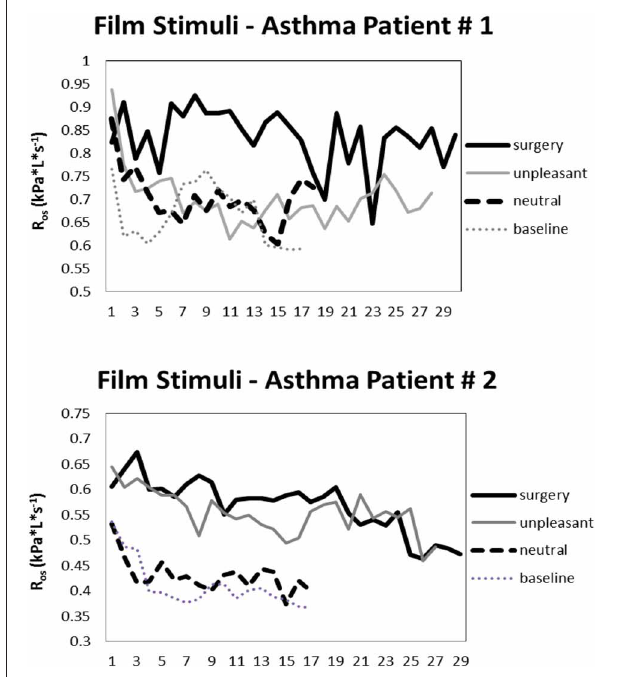
FIGURE 1 | Oscillatory resistance (consecutive 10-s means) in two exemplary asthmatic individuals during baseline and viewing of neutral, unpleasant, and surgery